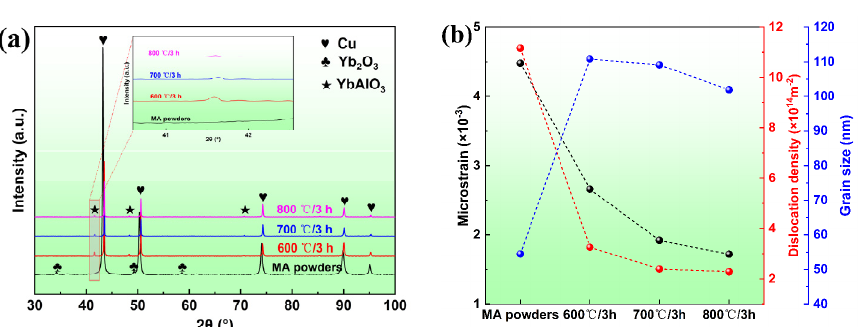
Figure 2. ( a ) XRD patterns of the MA powders and annealed alloys; ( b ) microstrain, grain size and dislocation density distribution in the MA powders and annealed alloys.